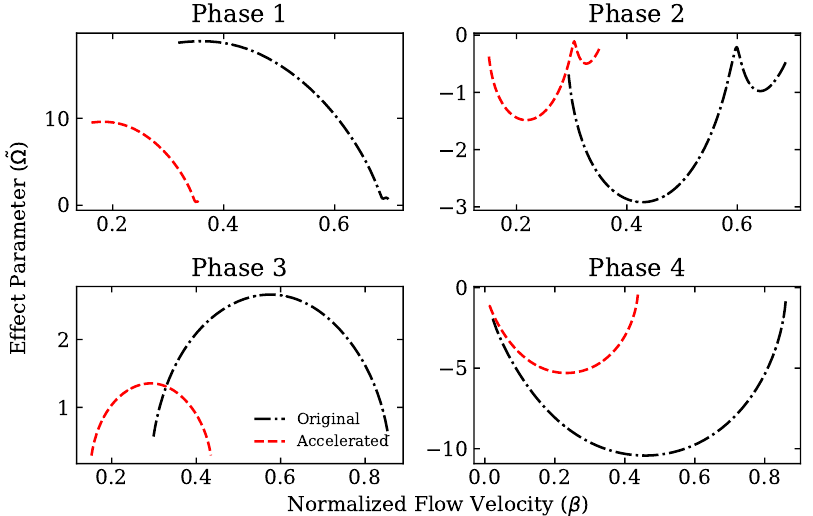
Figure 24. Scaled process curves of the flow velocity in discharging